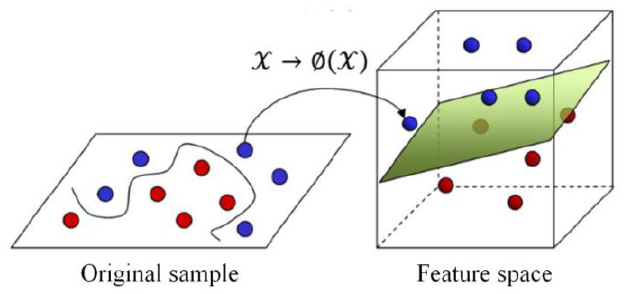
Figure 4. Schematic of Support Vector Regression.